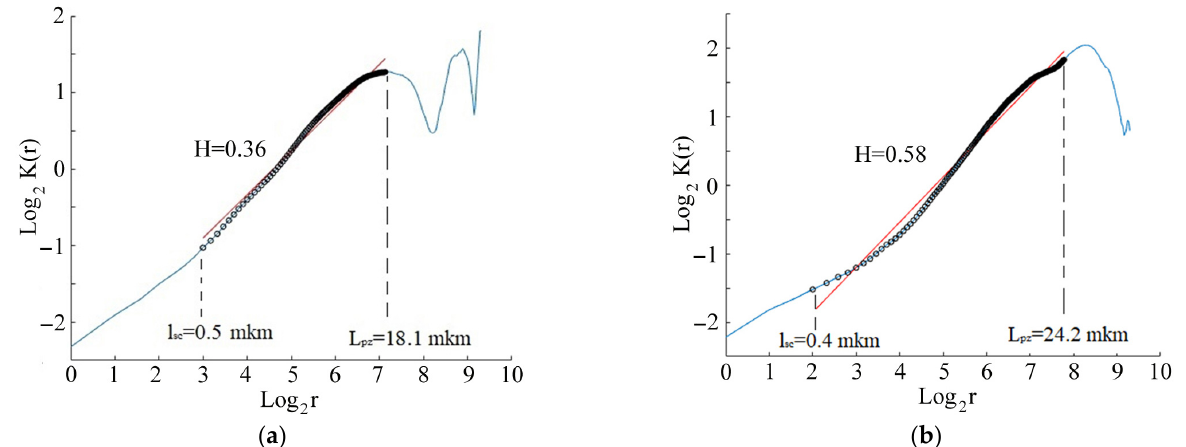
Figure 19. Dependence of log 2 K ( r ) on log 2 ( r ), Hurst exponent H and scales L pz and l sc of the UFG Ti45Nb alloy sample for ( a ) zone 1; ( b ) zone 2. The average Hurst exponent and critical scales L pz and l sc in zone 1 and zone 2 for CG and UFG Ti-45Nb alloy are illustrated in Table Table 3. Average Hurst exponent and critical scale L pz and l sc for the UFG and CG Ti-45Nb alloys. Stress Amplitude σ ,